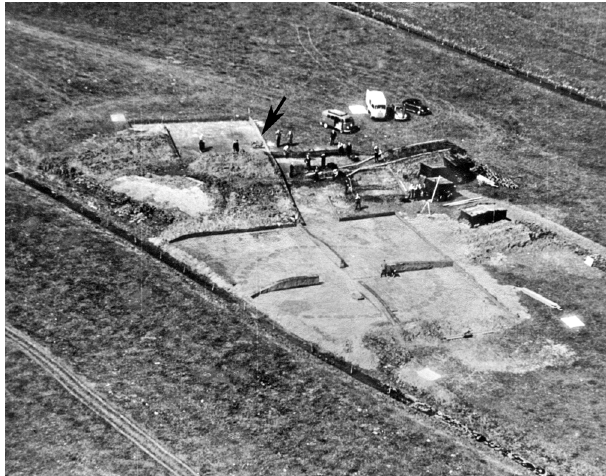
Figure 1: Aerial photo of the 1956 excavations of the two burial mounds at Oostwoud - Tuithoorn, led by Van Gi ff en. Burial 228 can be observed in the top centre ( black arrow )